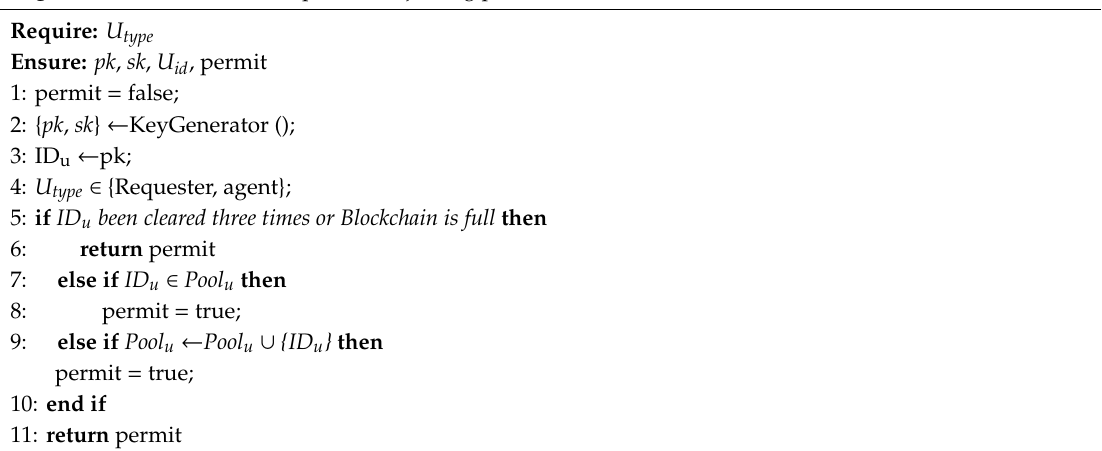
Algorithm 1. Authentication process in joining private